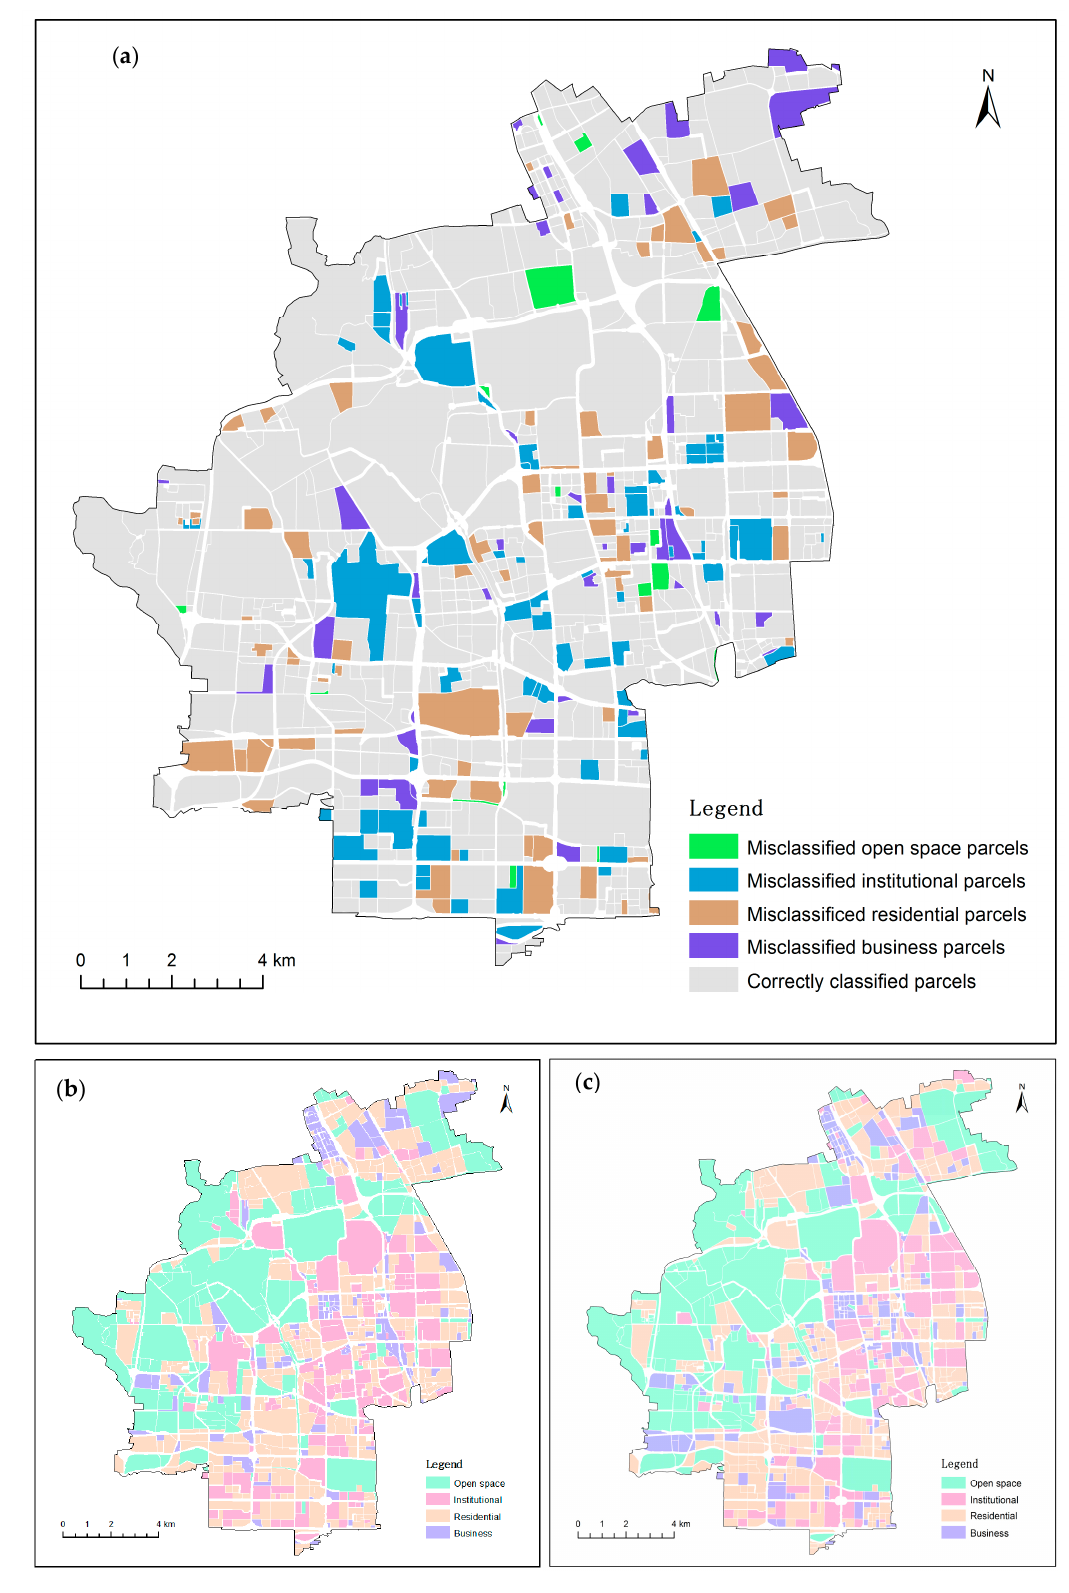
Figure 4. Misclassified parcels ( a ), actual ( b ) and predicted land use ( c ).